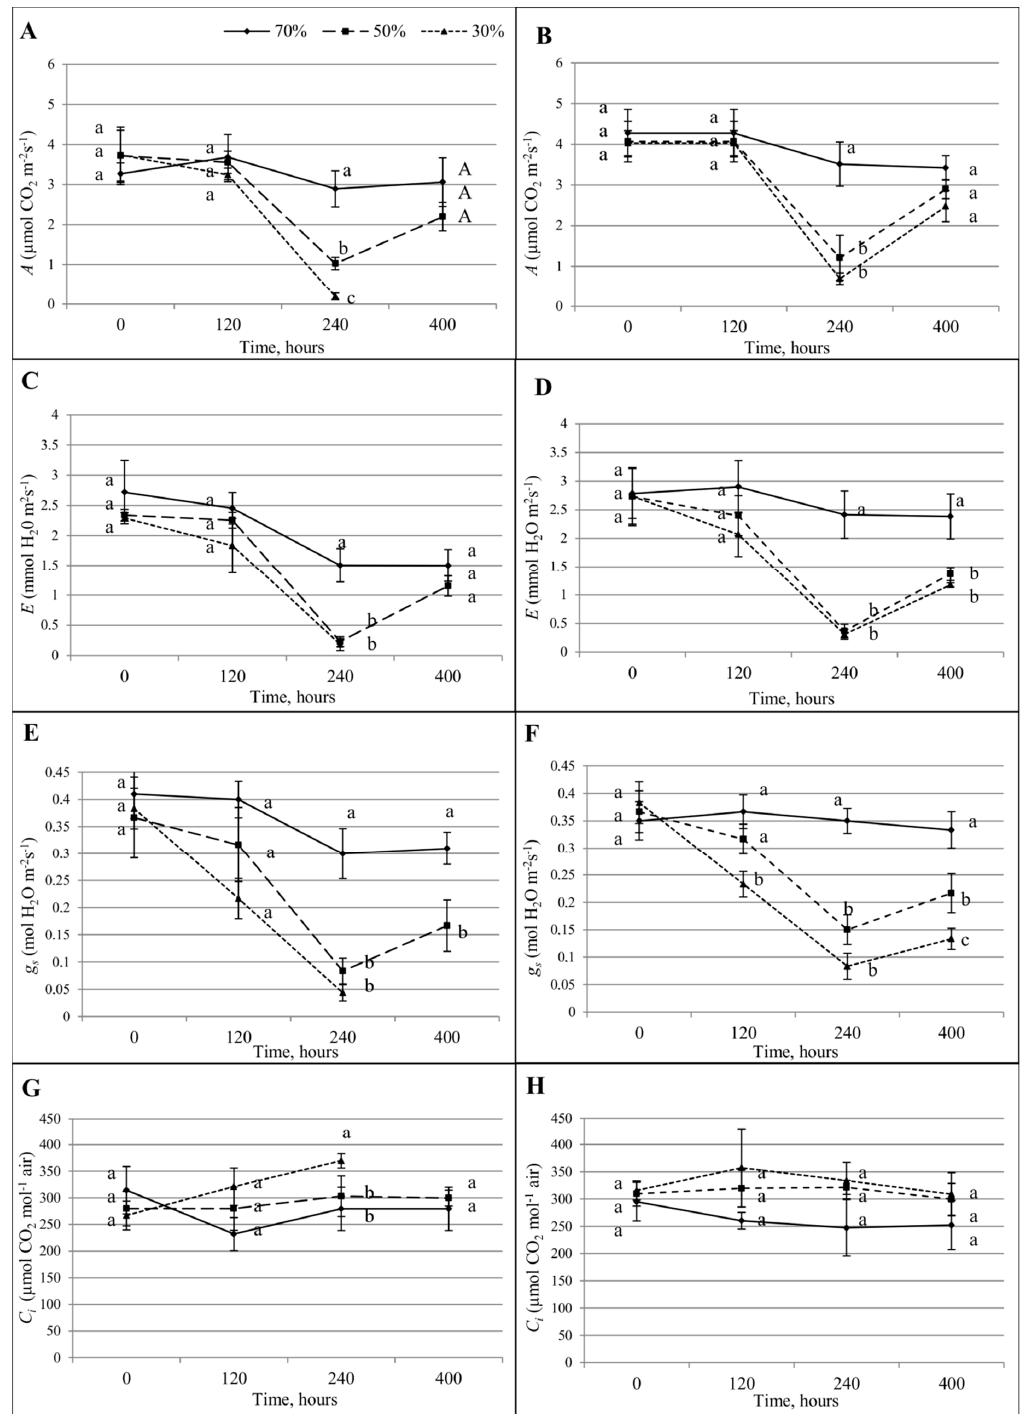
Figure 8. Gas exchange parameters ± S.D. of Roadrunner and Nira under di ff erent field water capacities (70, 50, and 30% FWC) and times after the application of stress (0, 120, 240, and 400 h). ( A ) CO 2 assimilation ( A ) in Roadrunner; ( B ) CO 2 assimilation ( A ) in Nira; ( C ) H 2 O transpiration ( E ) in Roadrunner; ( D ) H 2 O transpiration ( E ) in Nira; ( E ) stomatal conductance ( g s ) in Roadrunner; ( F ) stomatal conductance ( G s ) in Nira; ( G ) internal CO 2 concentration ( C i ) in Roadrunner; ( H ) internal CO 2 concentration ( C i ) in Nira. Mean values within a term marked by the same letter did not show significant di ff erences ( p < 0.05, n =